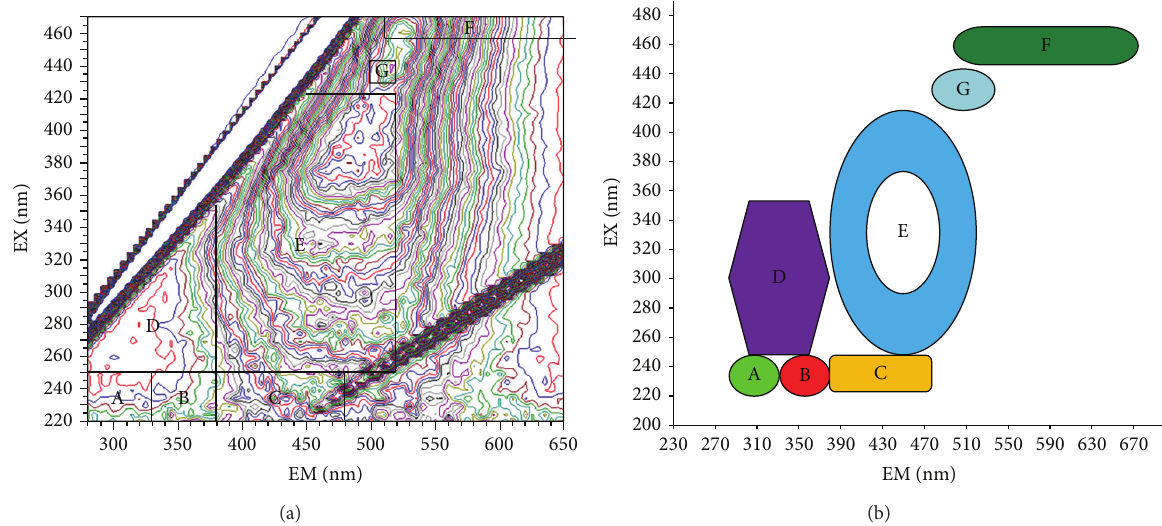
Figure 2: Schematic diagrams with partition method of fluorescent substances of GRSP by using 3D fluorescence spectrum. (a) Fingerprint of the partition of fluorescent substances; (b) pattern of the partition of fluorescent substances. Note: A: tyrosine-like protein, 220–250 nm in excitation and 280–330 nm in emission; B: tryptophan-like protein, 220–250 nm in excitation and 330–380 nm in emission; C: fulvic acid-like, 220–250 nm in excitation and 380–480 nm in emission; D: soluble microbial byproduct-like, 250–360 nm in excitation and 280–380 nm in emission; E: humic acid-like, 250–420 nm in excitation and 380–520 nm in emission; F: nitrobenzoxadiazole-like, 460–470 nm in